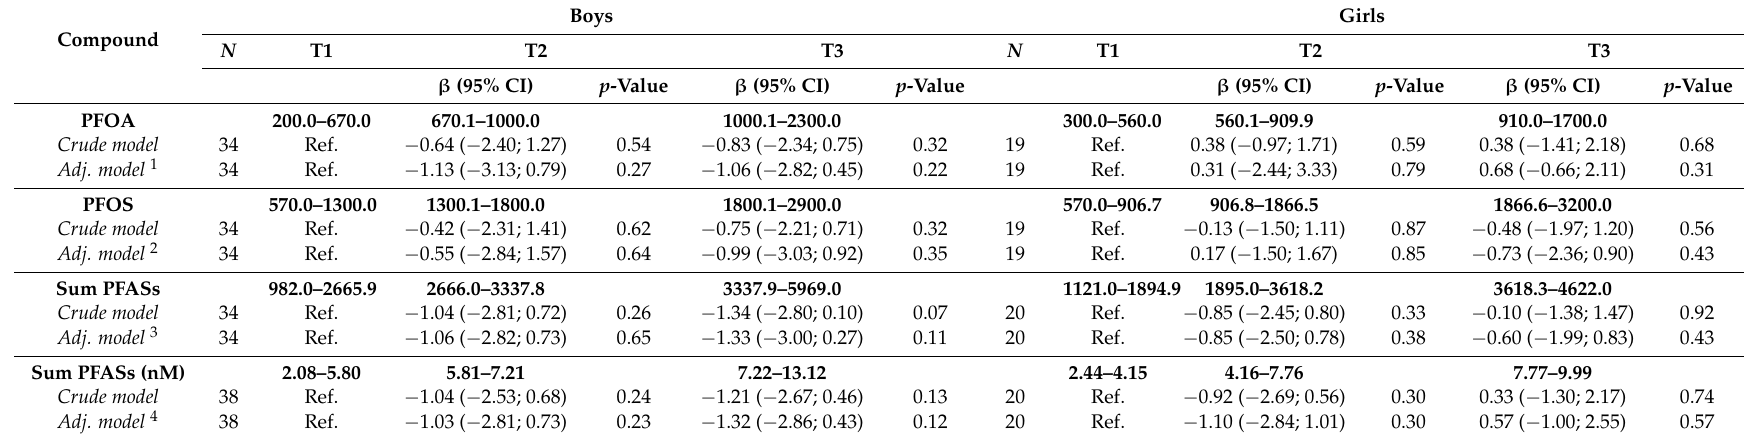
Table A3. Regression coefficients for exposure to perfluoroalkyl substances and scores on the Attention Deficit Hyperactivity Disorder scale of the CBCL, stratified for sex.